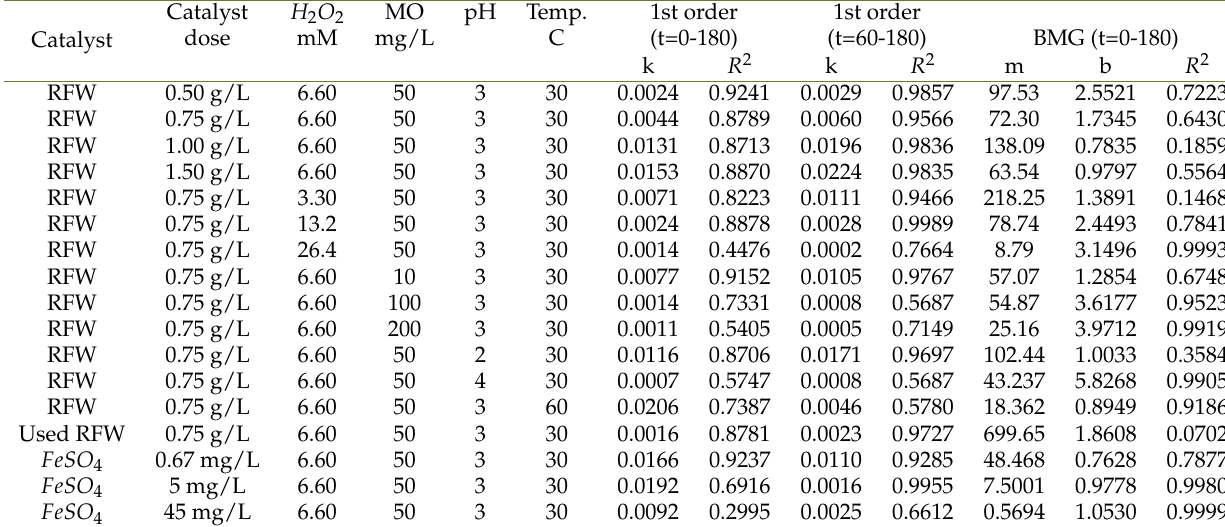
Table 1. Kinetic parameters of Fenton reaction by RFW